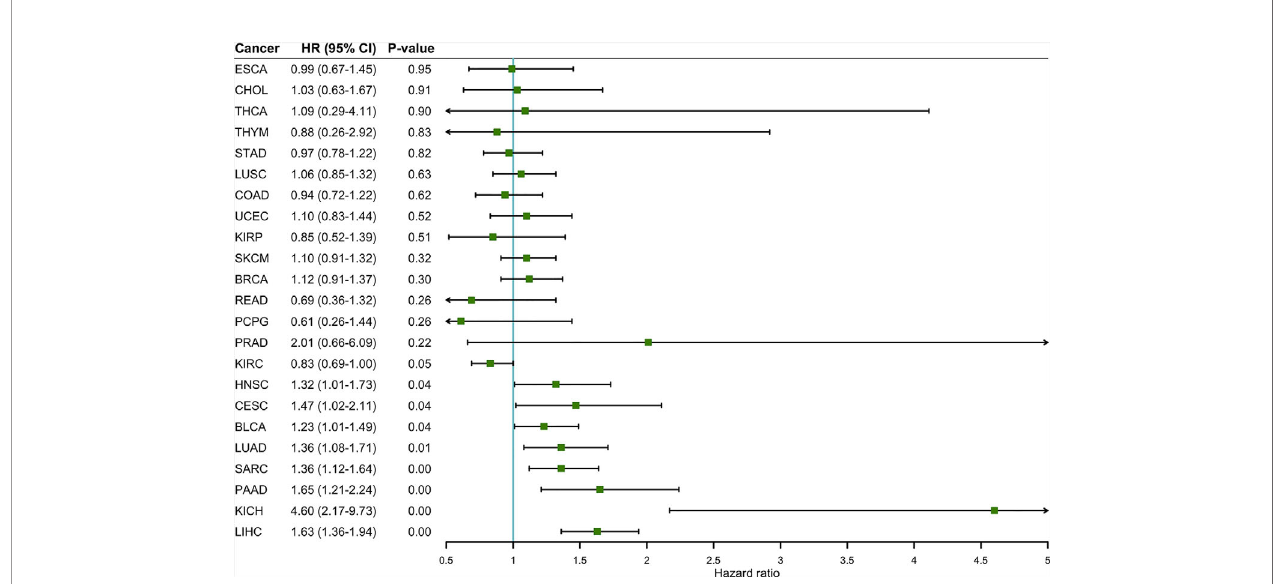
FIGURE 3 | The correlation between ENO1 expression and OS in 23 types of cancers. ENO1 expression signi fi cantly impacts prognosis in eight types of cancers, including HNSC, CESC, BLCA, LUAD, SARC, PAAD, KICH, and LIHC. High expression of ENO1 could be considered as an independent risk factor for the above 8 types of cancer (all HR > 1, P < 0.05). HNSC, head and neck squamous cell carcinoma; CESC, cervical squamous cell carcinoma and endocervical adenocarcinoma; BLCA, bladder urothelial carcinoma; LUAD, lung adenocarcinoma; SARC, sarcoma; PAAD, pancreatic adenocarcinoma; KICH, kidney chromophobe; LIHC, liver hepatocellular carcinoma; HR, hazard ratio; CI, con fi dence